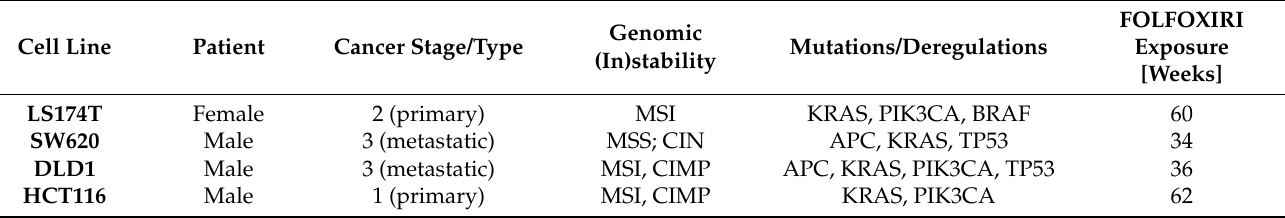
Table 1. CRC cell lines used in the study and their characterization